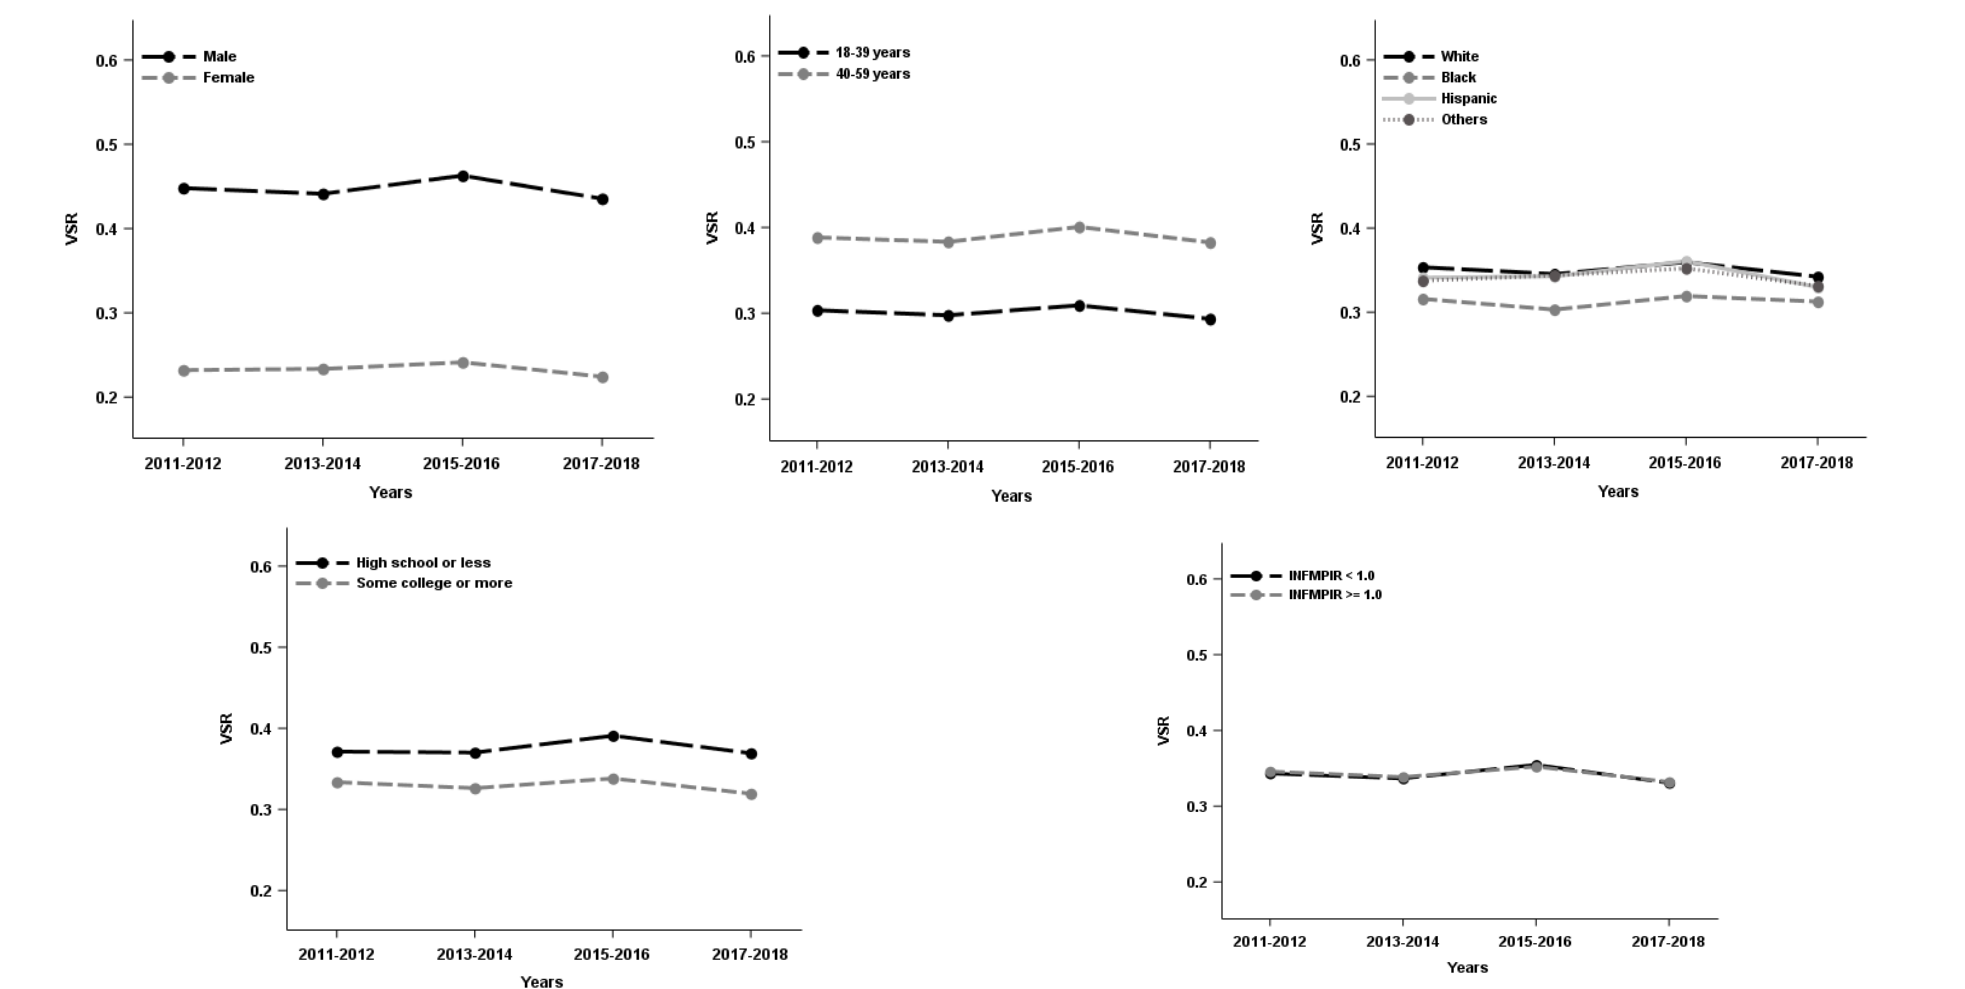
Figure 2. The visceral to subcutaneous adipose area ratio (VSR) trends in US adults by demographics, National Health and Nutrition Examination Survey 2011–2018. INFMPIR = the ratio of family income to the poverty level.